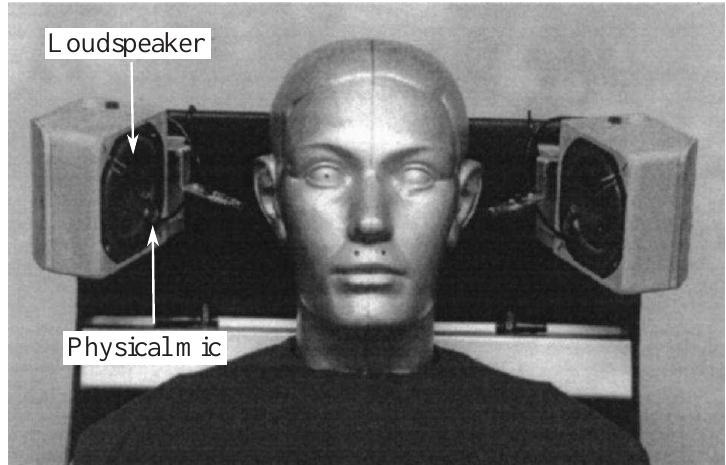
Figure 3. Local active headrest [23].